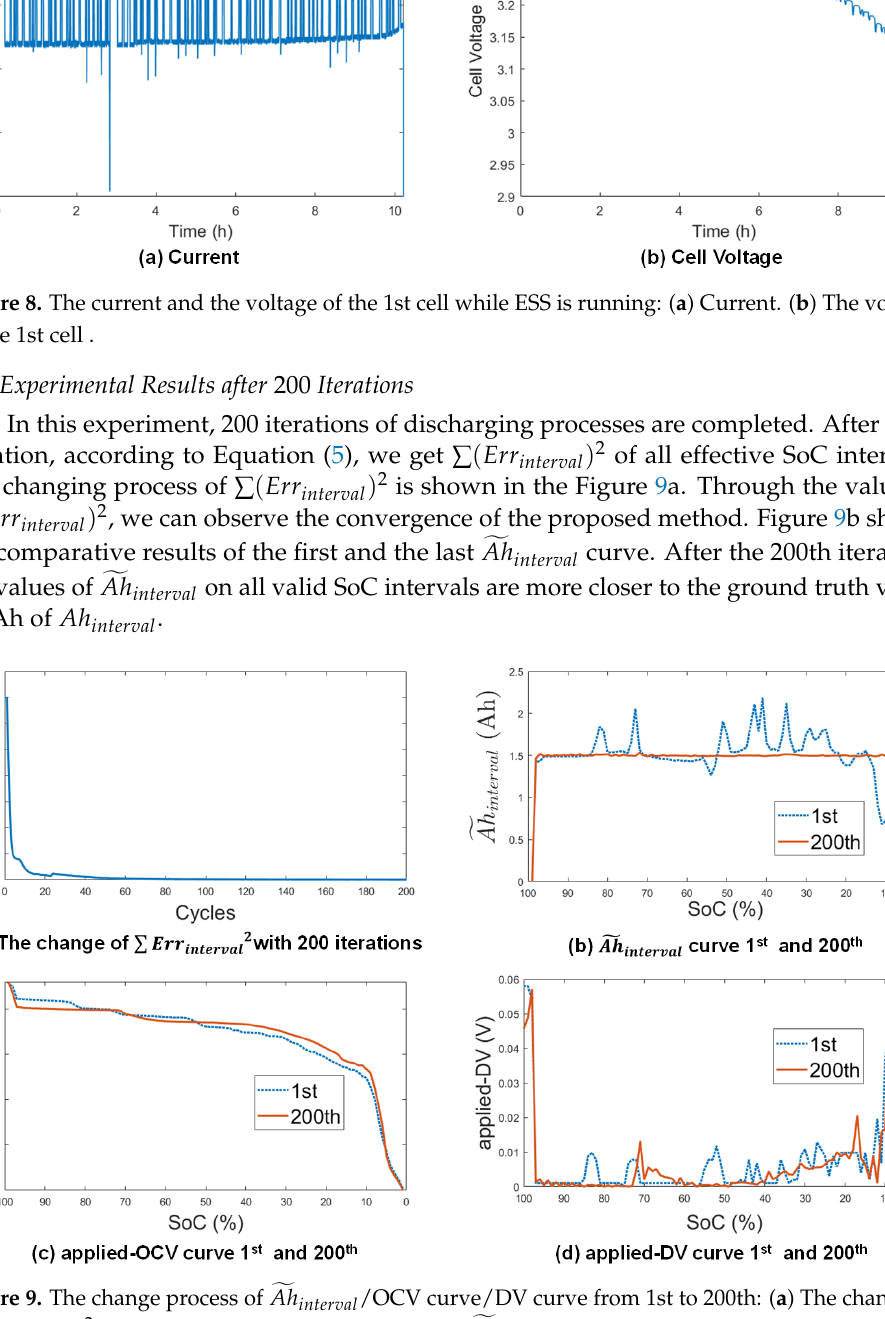
interval curve; ( c ) 1st and 200th applied-OCV